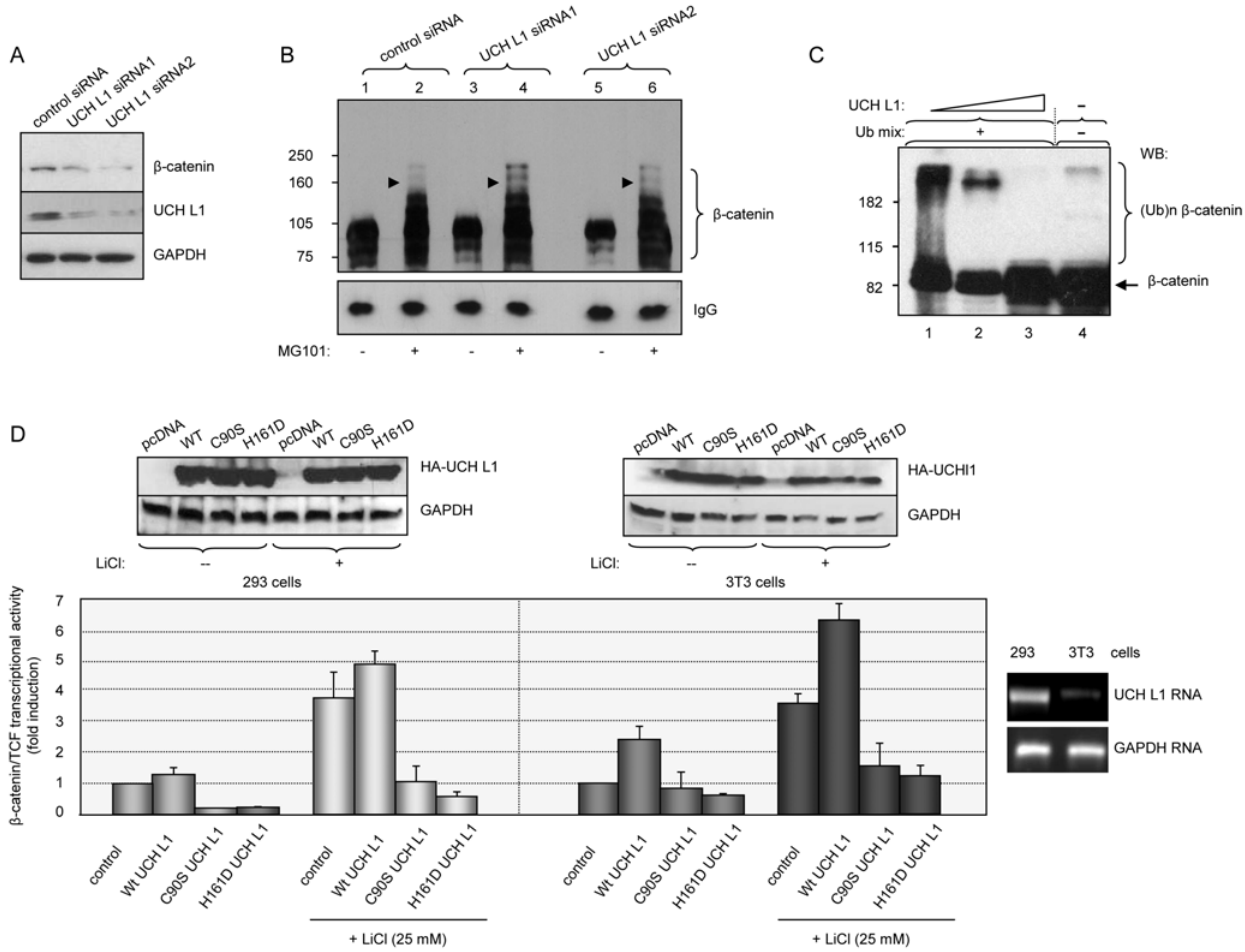
Figure 2. UCH L1 up-regulates b -catenin signaling. A. Reduction of expression of UCH L1 correlates with decrease in b -catenin protein levels. 293 cells were transfected with control GFP siRNA or two UCH L1 siRNAs in pRS vector and maintained in medium containing puromycin. After 3 weeks of selection total lysates from control- and si1/2 UCH L1-transfected cells were resolved in 12% PAGE, transferred to PVDF membrane and probed with b -catenin and UCH L1 antibodies. B. More b -catenin accumulates in UCH L1 siRNA-expressing cells in the presence of proteasome inhibitor. Stable 293 cell lines expressing control and UCH L1 siRNAs were treated for 4 h with 25 mM MG101 or DMSO as negative control. b -catenin was immunoprecicpitated from total lysates, IPs were resolved in 10% PAGE and probed with b -catenin antibodies. Mouse normal immunoglobulins were used as control for IPs. Arrow heads indicate ubiquitinated forms of b -catenin. C. UCH L1 is involved in deubiquitination of b -catenin invitro . b -catenin was in vitro -translated (lane 4) as described in Material and Methods. To induce further ubiquitination equal amounts of translated b -catenin were pre-incubated with Ub mix for 30 min, and an in-vitro deubiquitination reaction was carried out in the absence (lane 1) or presence of 2 or 4 mM recombinant UCH L1 (lanes 2 and 3). Western blot was performed with b -catenin antibody. D. Deubiquitinating activity of UCH L1 is required for TCF4 transcriptional activity. UCH L1 wild type or UCH L1 inactive mutants C90S and H161D were co-transfected with either TOPFlash or FOPFlash into 293 and 3T3 cells. Luciferase activity and expression of HA-UCH L1 proteins were determined 48 h post-transfection. Where indicated, cells were treated with 25 mM LiCl 6 h before harvesting. The data represent two independent experiments prepared in triplicate and normalized to FOPFlash